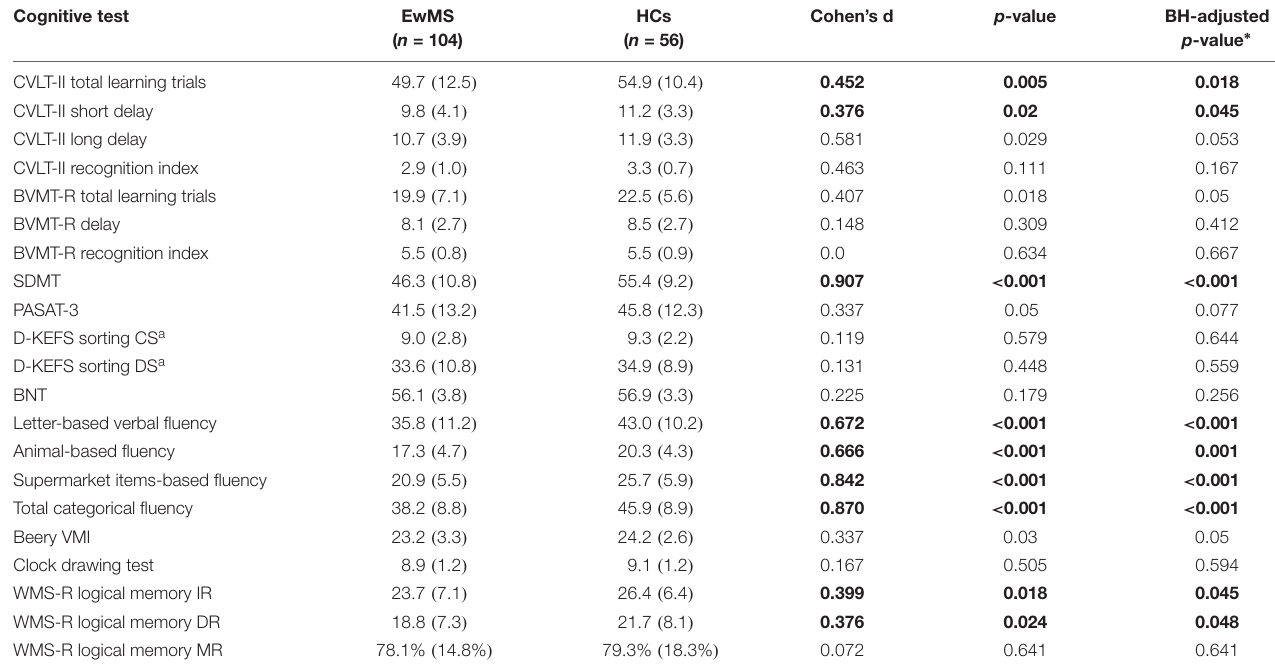
TABLE 3 | Cognitive performance of the EwMS and HCs populations on the minimal assessment for cognitive function in multiple sclerosis (MACFIMS) battery. Cognitive test EwMS ( n = 104)